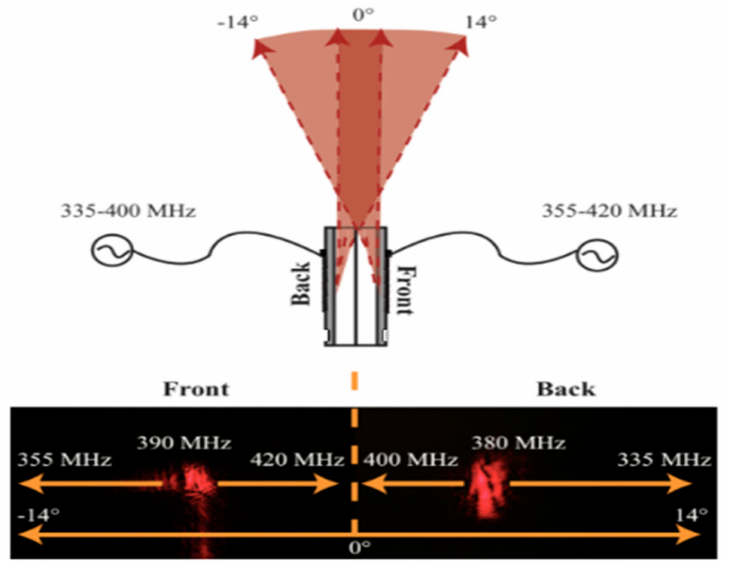
Figure 14. Stacked leaky mode modulators from Qaderi et al. Reprinted with permission from [13] © The Optical Society.